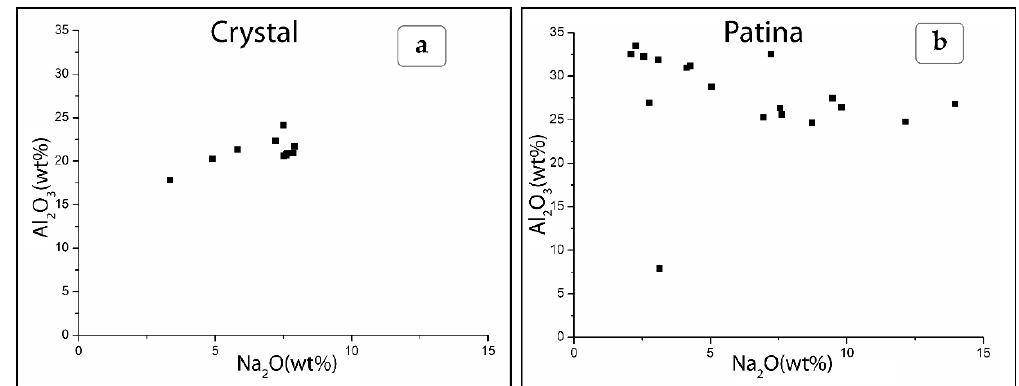
Figure 8. Diagrams show the cations mobilization of Na 2 O and Al 2 O 3 , from the crystal to the patina developed during the alteration process affecting the plagioclase grains at temperature of 150 °C and 175 °C and pH 5 and 3.5, respectively. ( a ) Diagrams showing the composition of the plagioclase. ( b ) B-plot showing clear increase of Na 2 O and Al 2 O 3 in the patina developed on plagioclase.